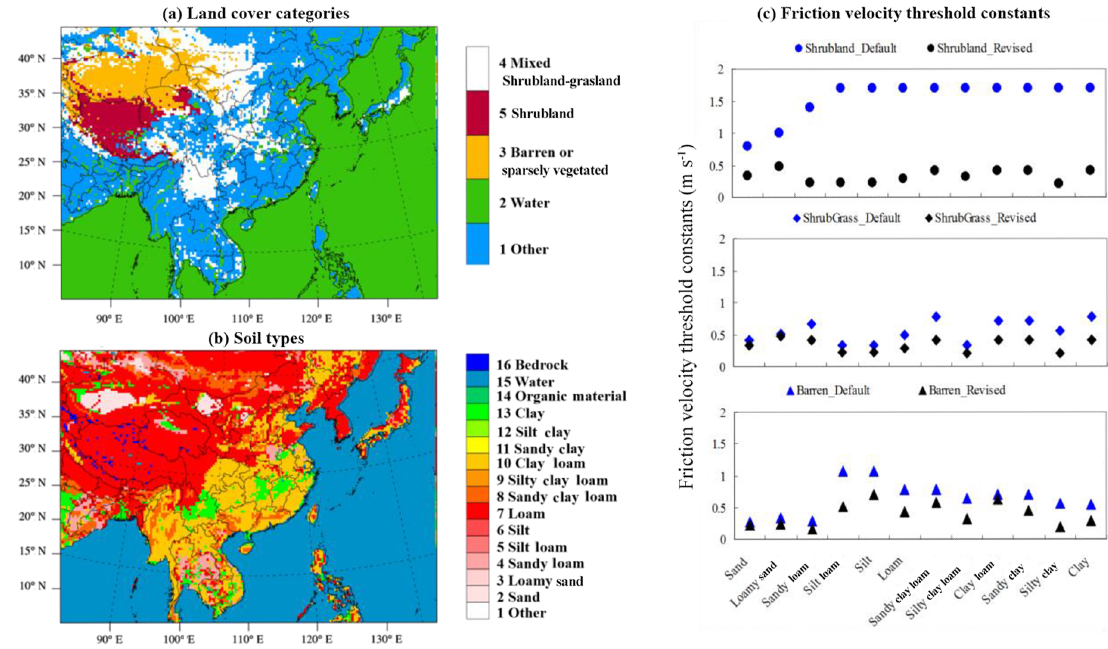
Figure 1. (a) Land cover categories, (b) soil types, and (c) comparison of initial friction velocity threshold constants in default (blue markers) and revised (black markers) dust schemes for shrubland (top), mixed shrub- and grassland (middle), and barren or sparsely vegetated (bottom) land